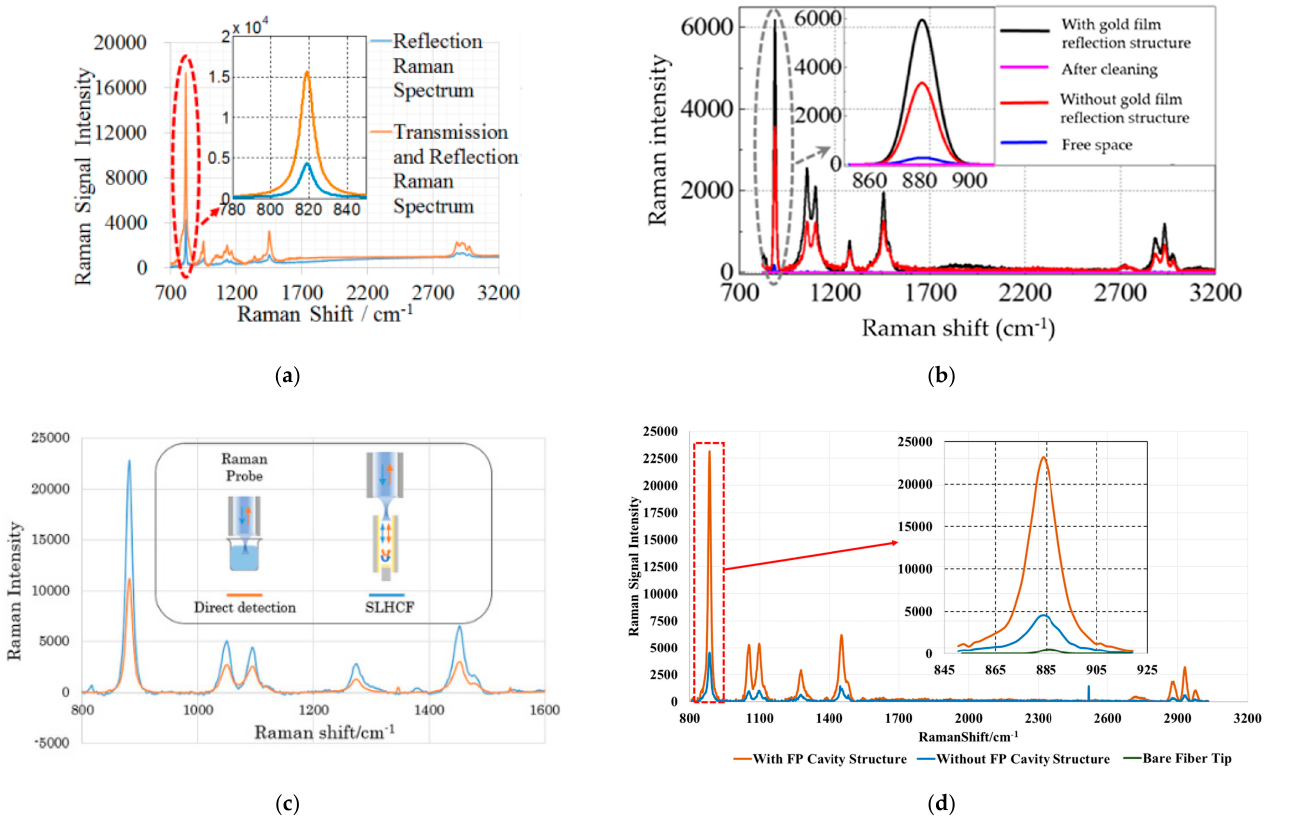
Figure 15. Raman signal enhancement experiment results of different structures. ( a ) Raman spectrum of ISO in Sagnac loop. © (2018) IEEE. Reprinted, with the permission, from [32]. ( b ) Raman spectrum of ethanol in capillary with an inserted reflector. Reproduced with permission [10]. ( c ) Comparison of Raman spectra for ethanol detected by SLHCF and direct detection [27]. ( d ) Raman spectrum of ethanol in an inserted FP cavity. Reprinted with permission from [46] © The Optical Society.